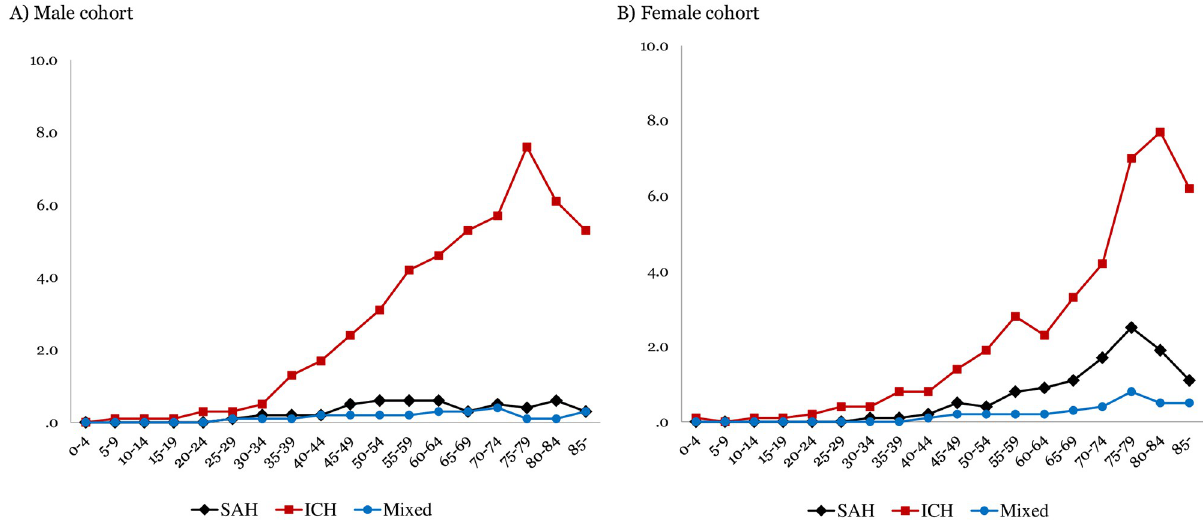
Fig 2. Age- and sex-specific incidence rates of spontaneous hemorrhagic stroke with emergency neurosurgery. SAH, subarachnoid hemorrhage; ICH, intracerebral hemorrhage.